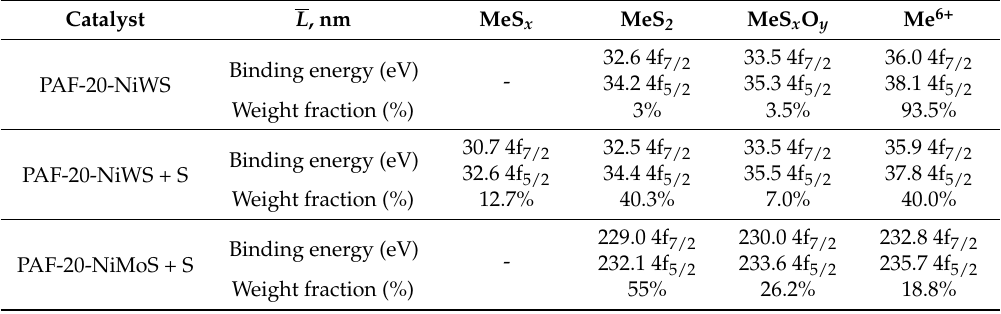
Table 2. X-ray photoelectron spectroscopy (XPS) data for the W4f and Mo3d Table 2. X ‐ ray photoelectron spectroscopy (XPS) data for the W4 f and Mo3 d levels. Catalyst